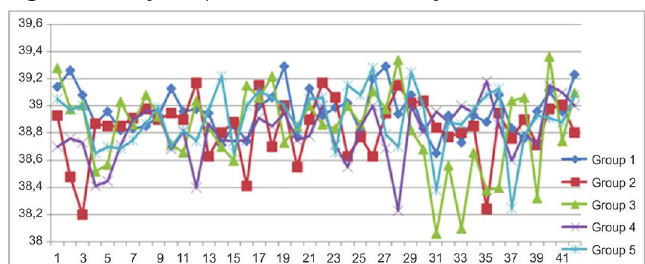
Figure 1 - Body temperature of rabbits in dynamics